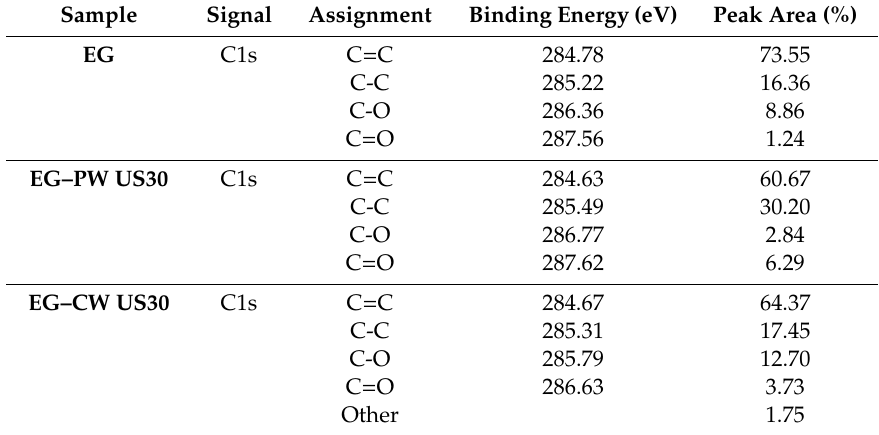
Table 5. Relative area percentages of functional groups found for EG samples and calculated from C1s XPS